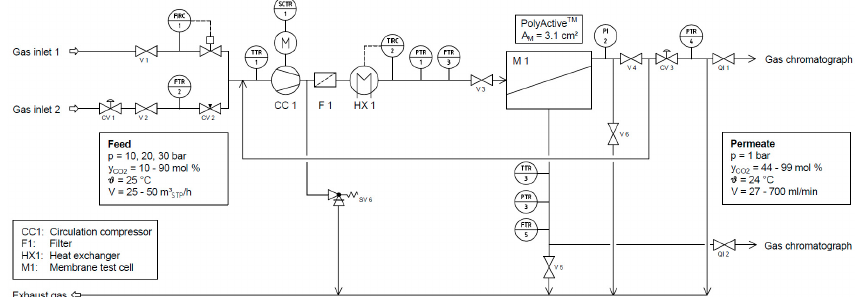
Figure 4. Flowsheet of experimental facility for gas separation experiments up to 30 bar at constant temperatures (CV: control valve, FI: flow indicator, FIRC: flow indicating recording controller, FTR: flow transmitting recorder, PI: pressure indicator, PTR: pressure transmitting recorder, QI: quality indicator, SCTR: speed controlling transmitting recorder, SV: safety valve, TI: temperature indicator, TIRC: temperature indicating recording controller, TTR: temperature transmitting recorder, V: valve).